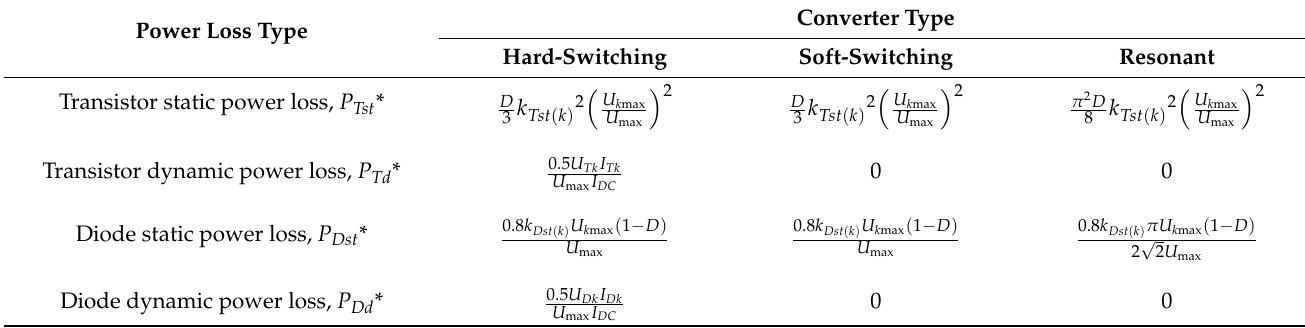
Table 2. Normalized power loss of the transistor and diode for DC – DC converters.